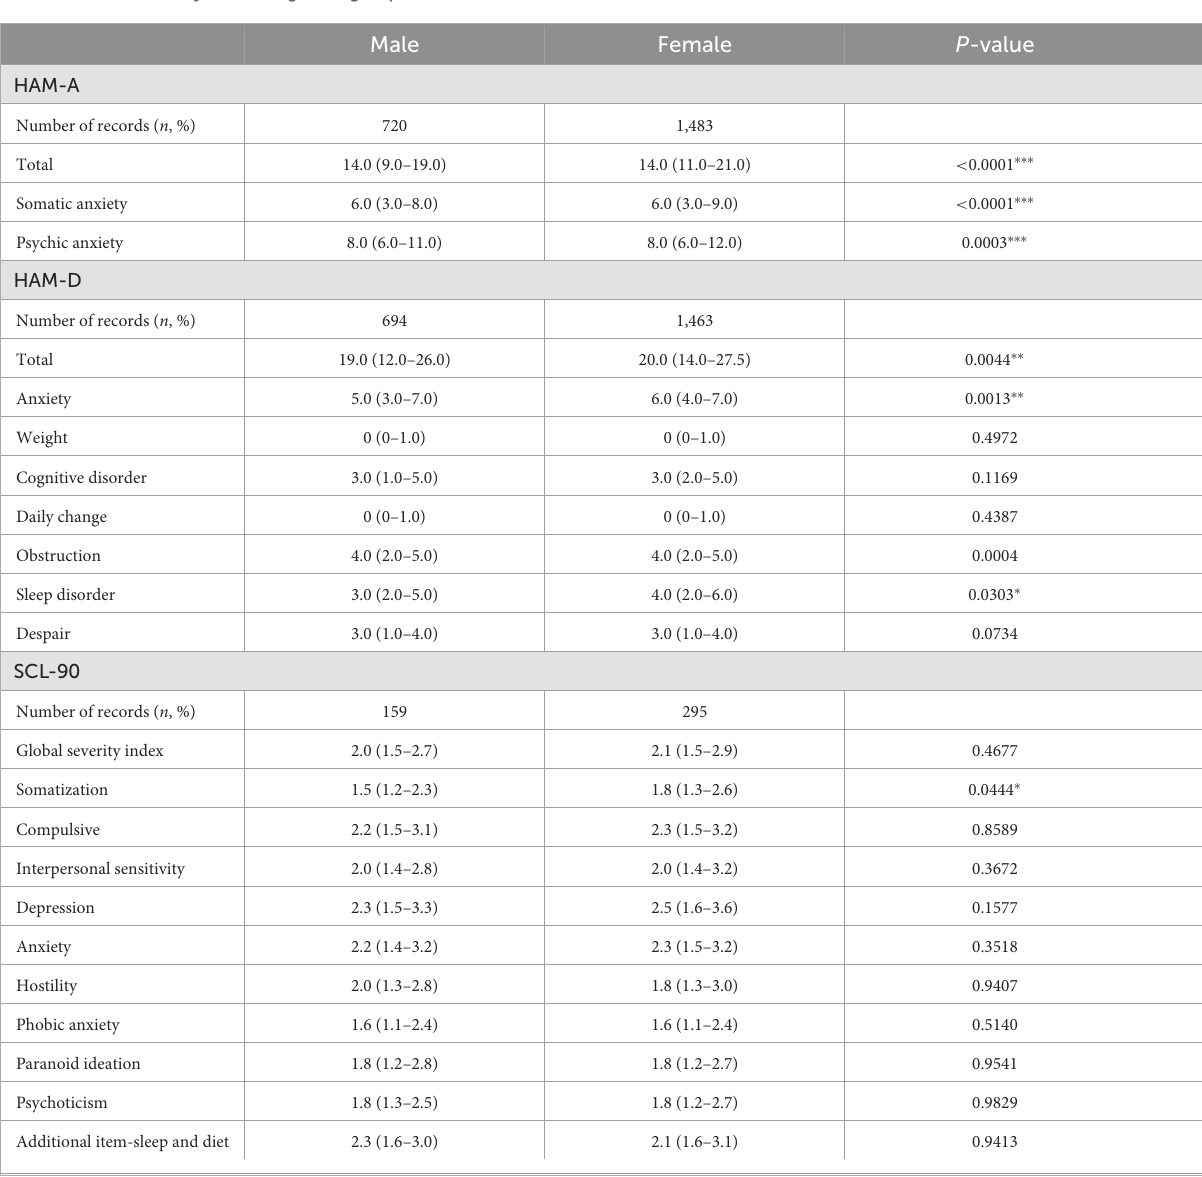
TABLE 2 Mann–Whitney U test for gender groups. Male Female P